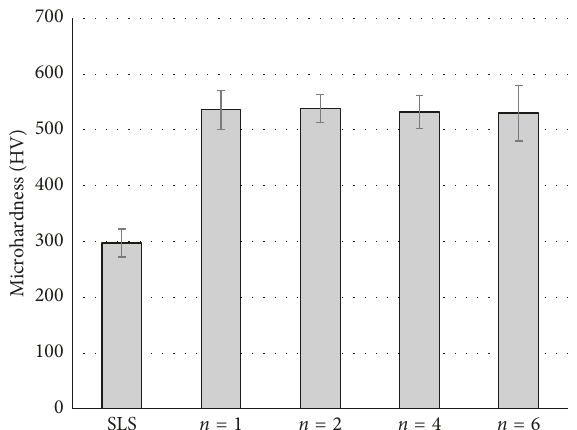
Figure 9: Microhardness of surfaces laser-processed 1, 2, 4, and 6 times (2.5mm/s; 2.5W). SLS: as-manufactured SLS sample.